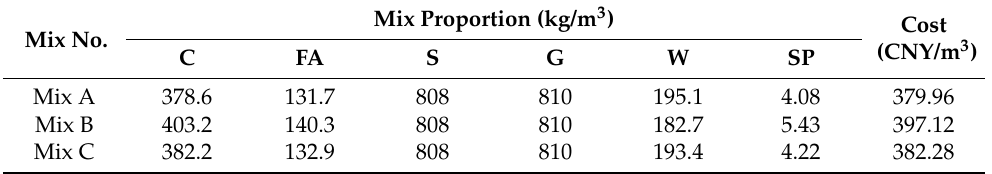
Table 17. The mix proportions and costs of different mix points in performance-based mix design. Mix Proportion (kg/m 3 Mix No.